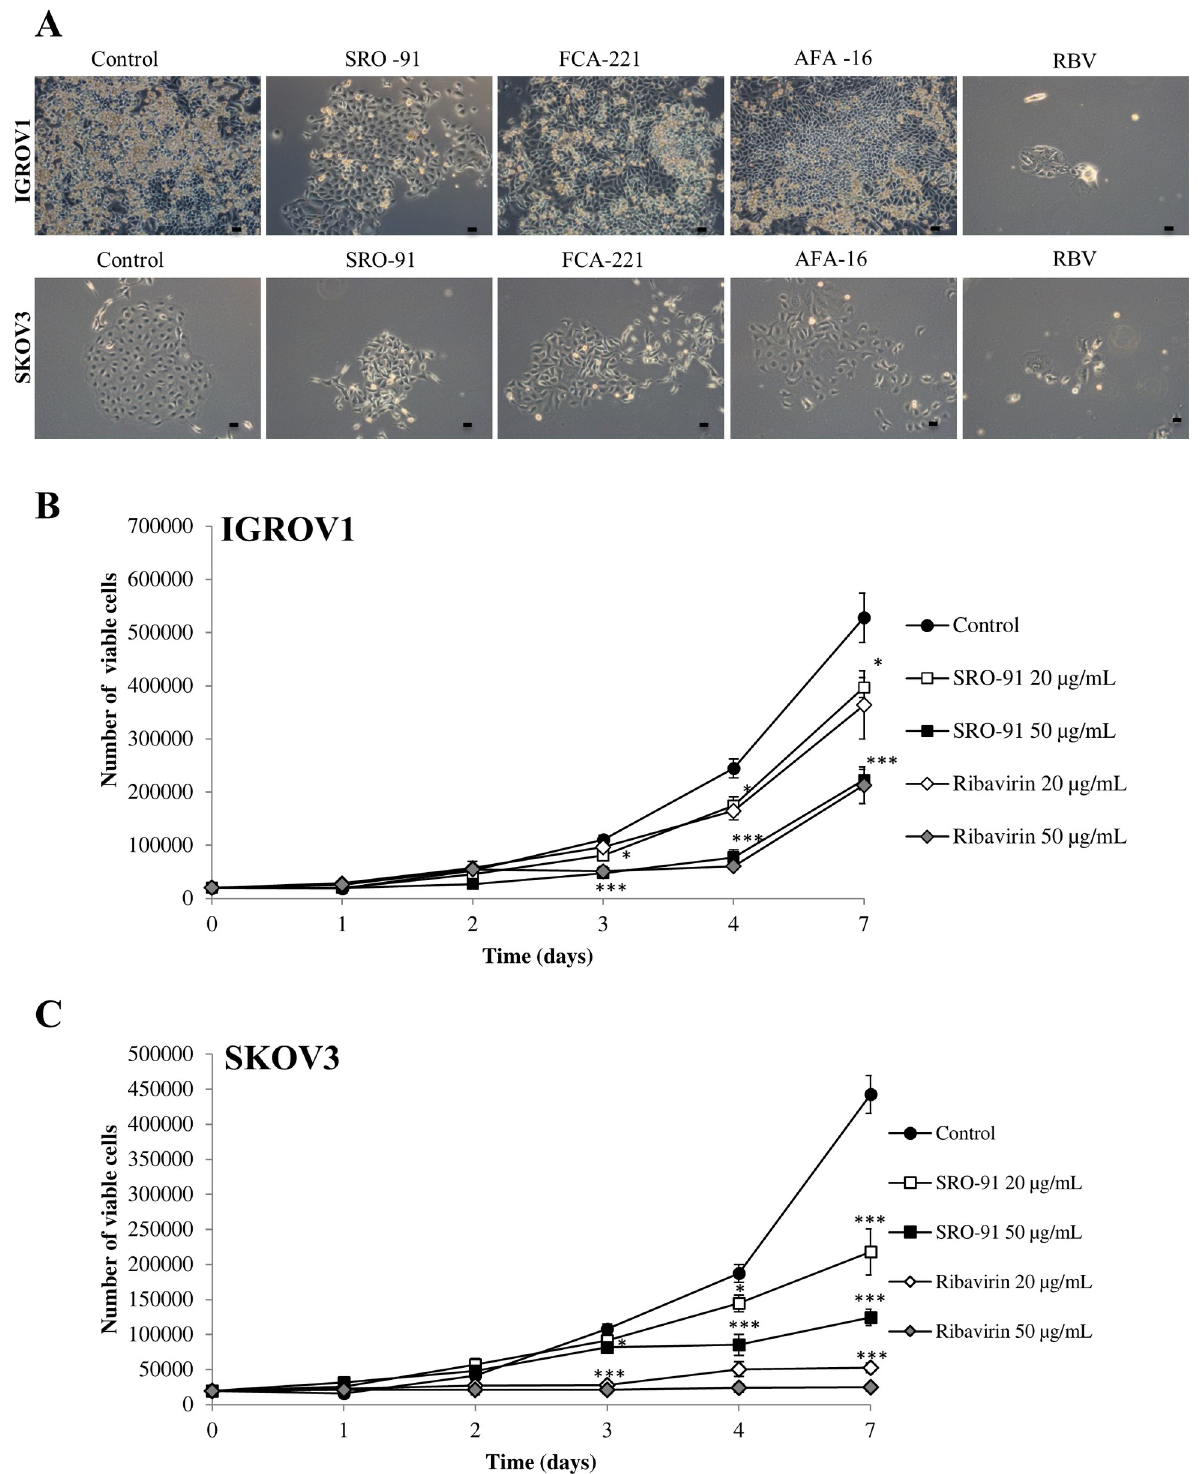
Fig 2. Viability of cancer cells after SRO-91 or ribavirin treatment. IGROV1 and SKOV3 were exposed to ribavirin analogs SRO-91, AFA-16, FCA-221 or ribavirin from 0 to 50 μ g/mL for 7 days of culture. (A) Representative light micrographs were taken on day 7 (scale bar 50 μ m). The number of viable (B) IGROV1 or (C) SKOV3 cells was measured daily by the trypan-blue exclusion test. Results are representative of 3 or more independent experiments done in triplicate, and are expressed as mean ± standard deviation. The inhibition of viable cells was significant from 3